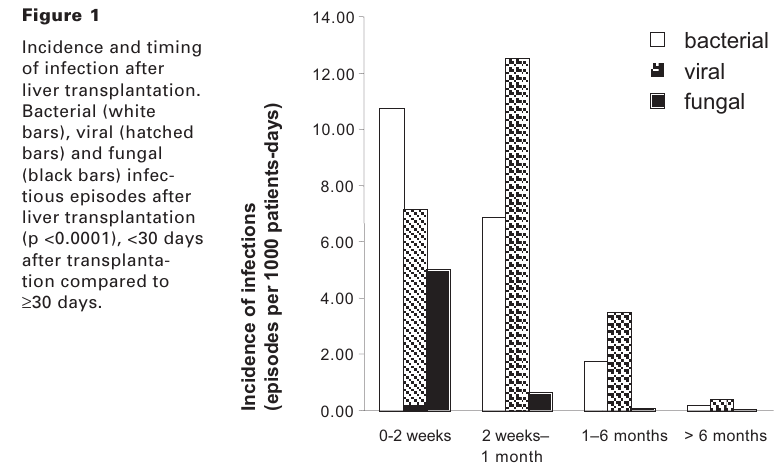
Figure 1 Incidence and timing of infection after liver transplantation. Bacterial (white bars), viral (hatched bars) and fungal (black bars) infec- tious episodes after liver transplantation (p <0.0001), <30 days after transplanta- tion compared to 0 30